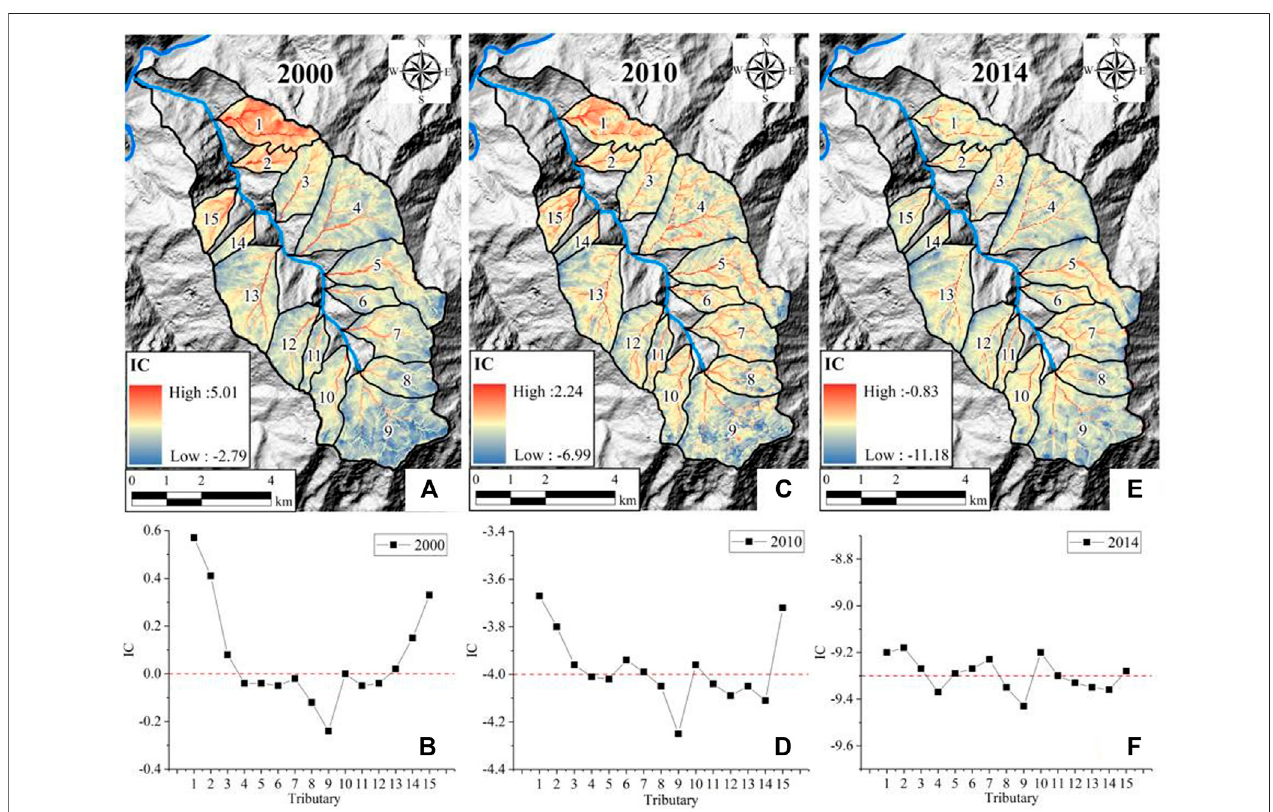
FIGURE10| DistributionoftheICvaluesinthe15tributaries. (A) Sedimentconnectivityin2000,priortothe2008WenchuanEarthquake. (B) MeanICvaluesofthe 15tributariesin2000. (C) Sedimentconnectivityin2010. (D) MeanICvaluesofthe15tributariesin2010. (E) Sedimentconnectivityin2014. (F) MeanICvaluesofthe15 tributaries in 2014.